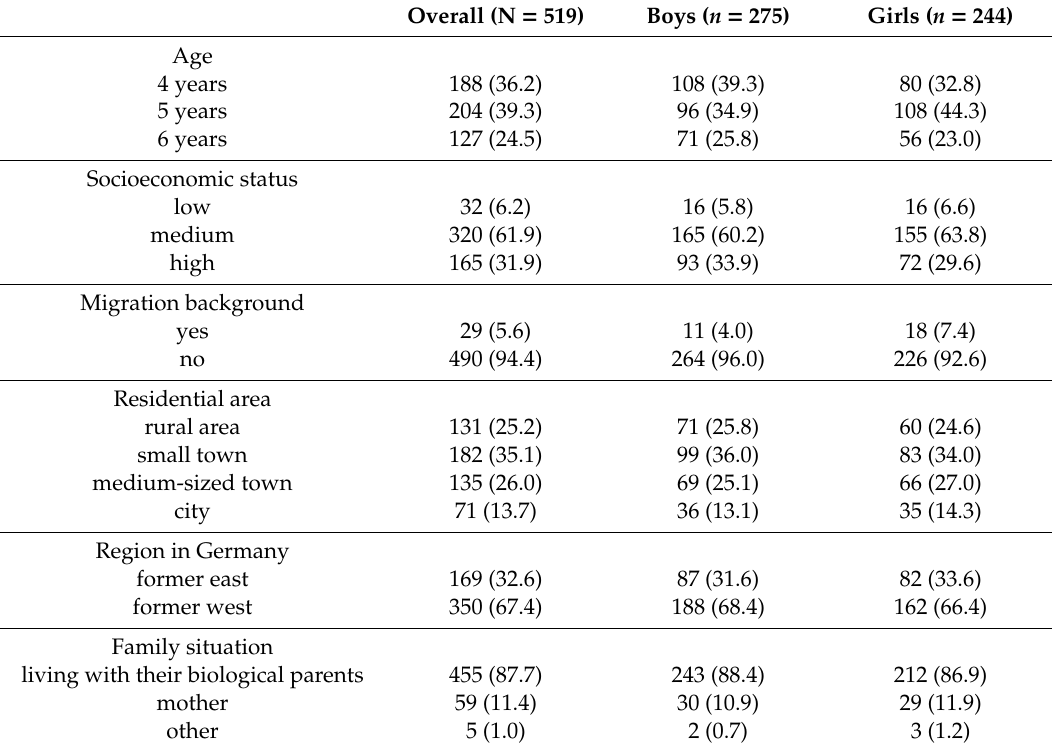
Table 1. Description of the study sample [ n (%)].